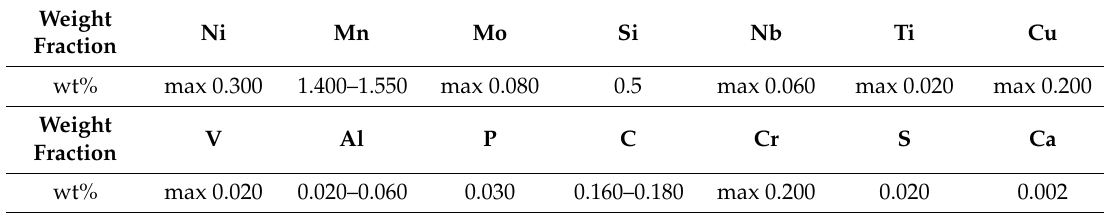
Table 2. Chemical composition of steel